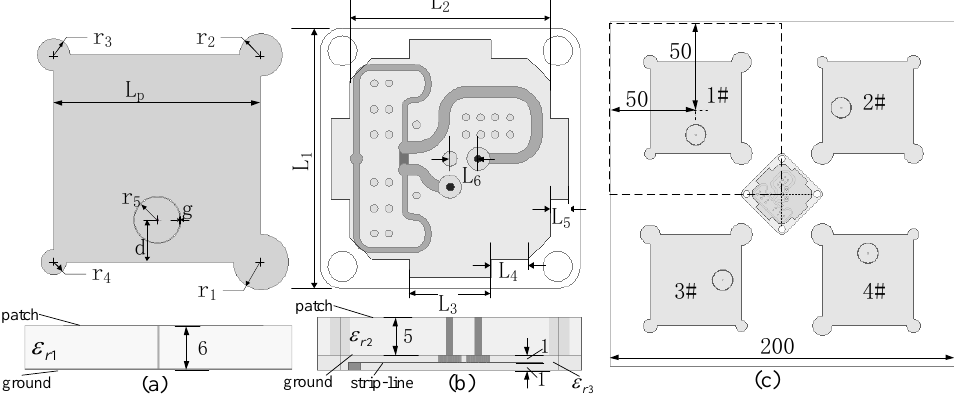
Figure 1. The top and side view of the ( a ) Beidou Navigation Satellite System (BDS), ( b ) GPS/GLONASS antenna, and ( c ) top view of the array with poor